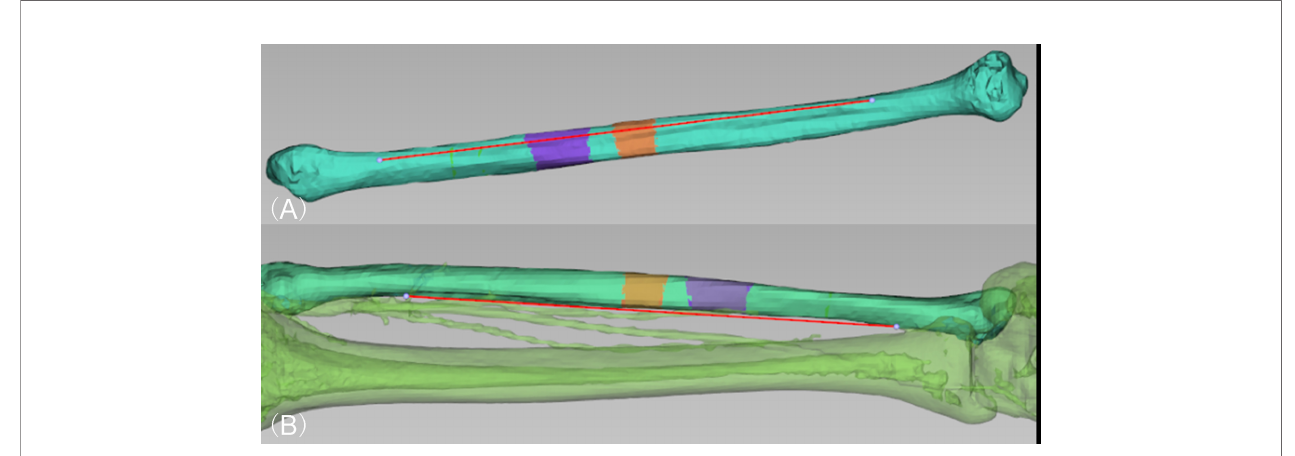
FIGURE 2 | Virtual surgery simulation of designing the location fi bular fl ap osteotomy. (A) Determination of proper osteotomy location and arrangement of all segments on the virtual fi bula model (purple and orange). (B) The fi bular fl ap was designed in consideration of preserving proper length at the distal end of the fi bula as well as the location of proximal end of the peroneal